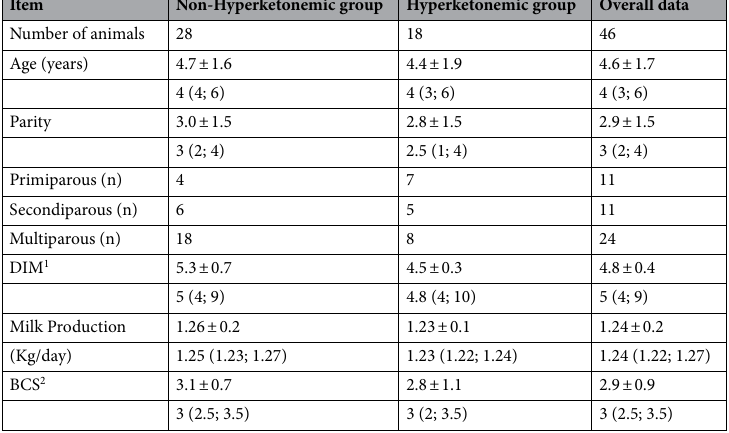
Table 1. Group descriptive data as means ± standard deviation and as median (first quartile; third quartile). 1 Days in milk. 2 Body condition score.